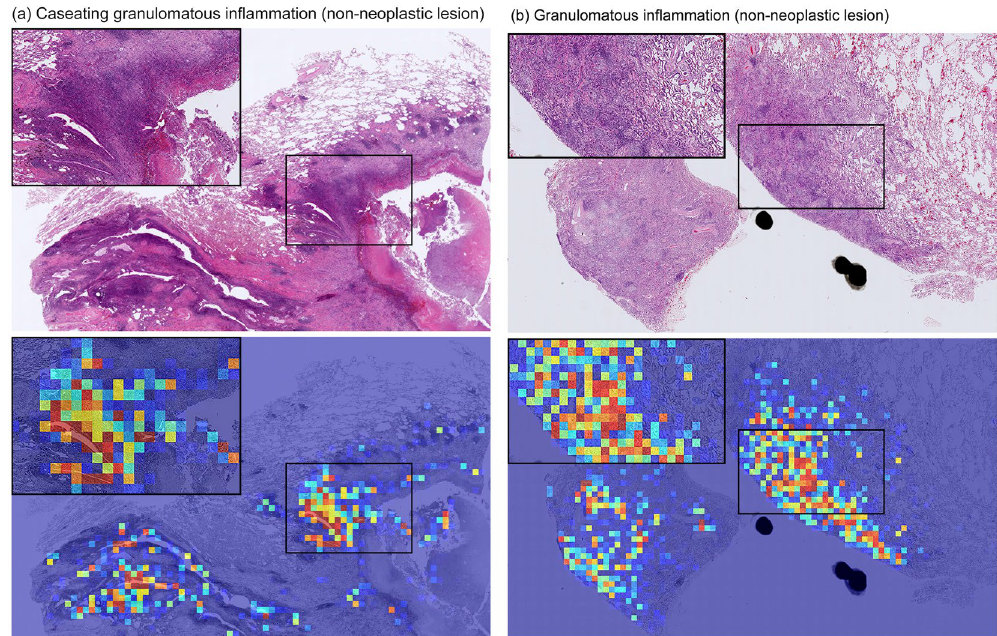
Figure 4. Examples of two carcinoma false positive prediction outputs using the fully-supervised method. Both were correctly predicted as non-neoplastic by the weakly-supervised method. ( a ) is a case of caseating granulomatous inflammation 36 which consists of necrotic tissues (caseation necrosis is defined as a region in granulomas with eosinophilic, granular and cheese-like cellular debris with necrosis) and chronic inflammation. ( b ) is a case of granulomatous inflammation 37 , which is a distinctive form of chronic inflammation produced in response to various infection. The inflammatory tissue is the main cause of false positives due to its analogous tissue structure to cancer